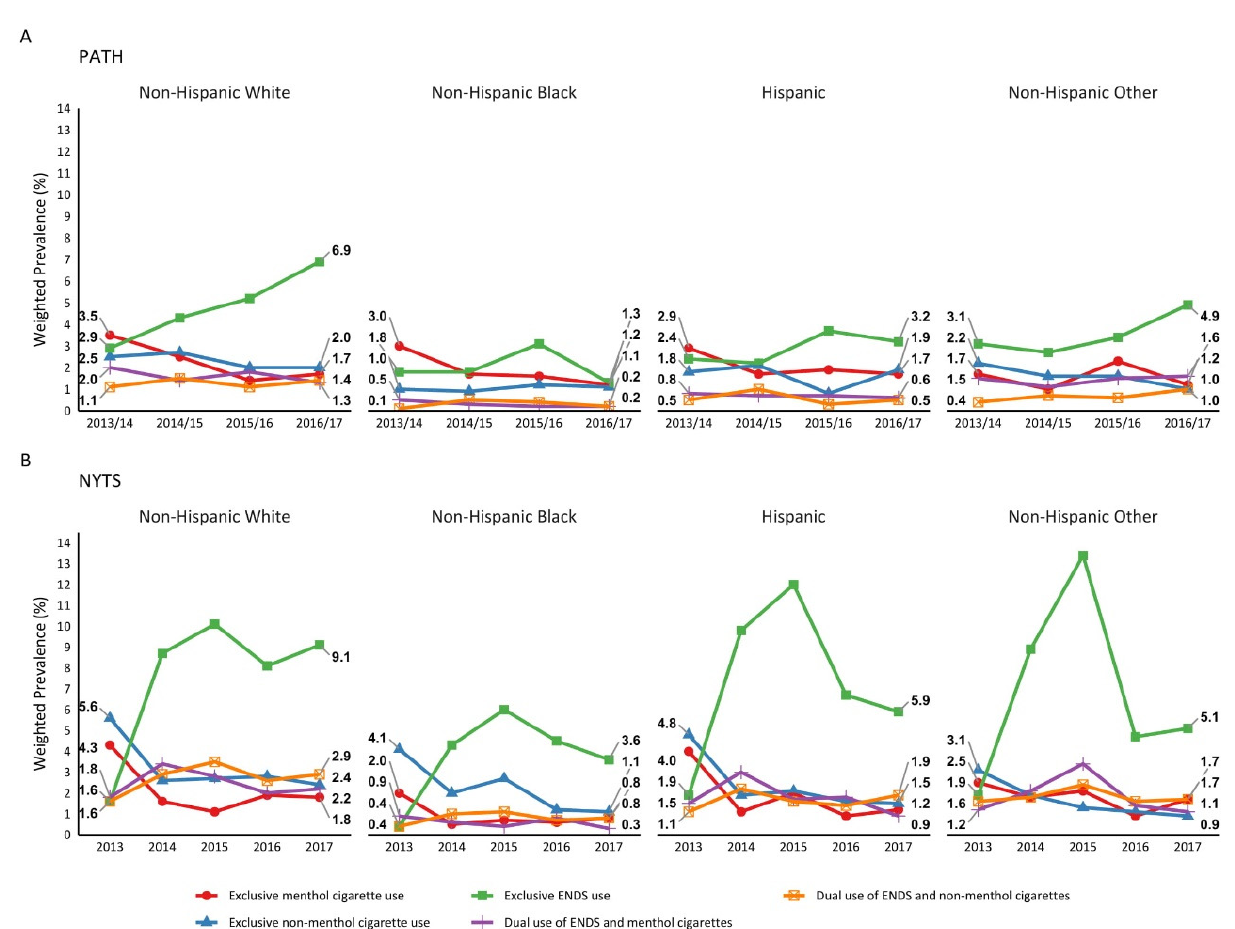
Figure 1. Prevalence of exclusive and dual use of ENDS and menthol/non-menthol cigarettes by race/ethnicity in ( A ) PATH and ( B ) NYTS.